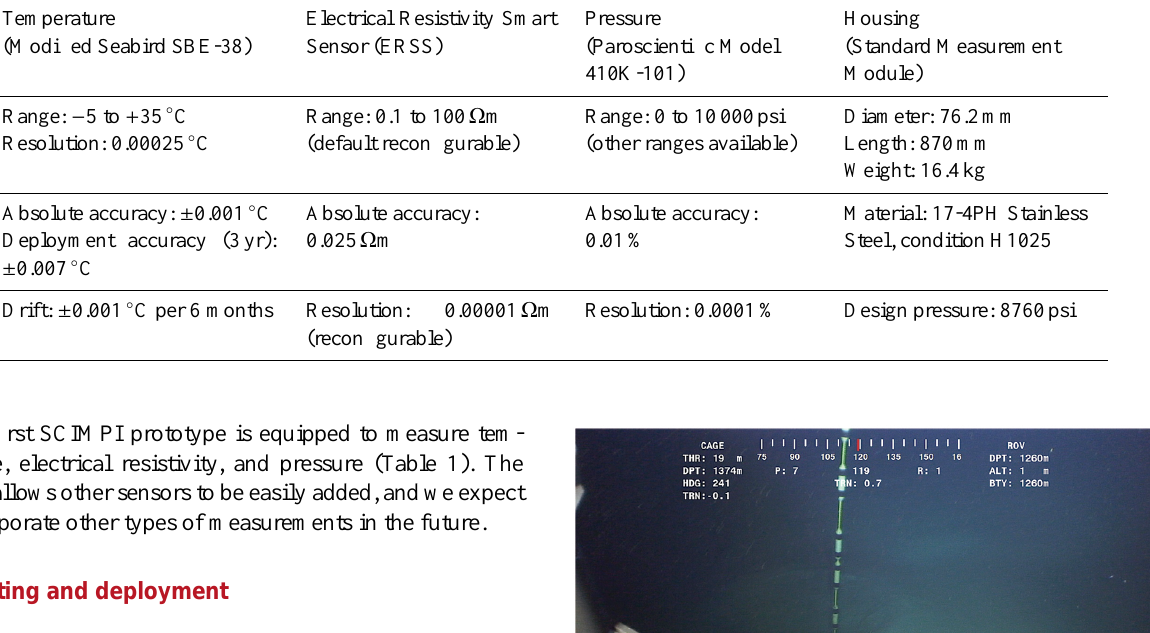
Table 1. Specifications of the SCIMPI prototype.